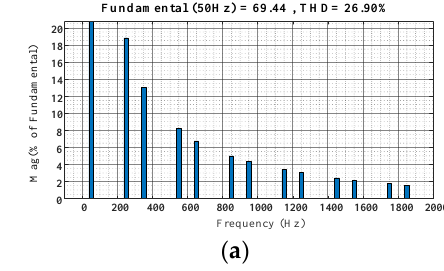
Figure 17. Mode 2 harmonic analysis diagram. ( a ) Harmonic analysis diagram before harmonic treatment. ( b ) Harmonic analysis diagram after harmonic treatment.